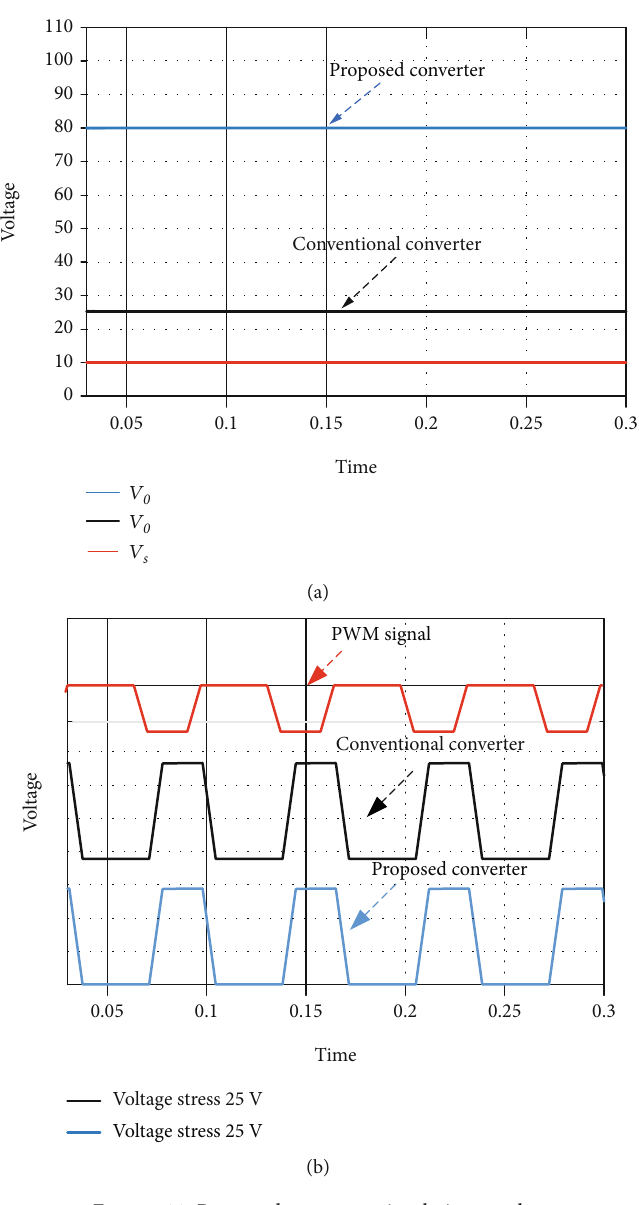
Figure 11: Proposed converter simulation results.